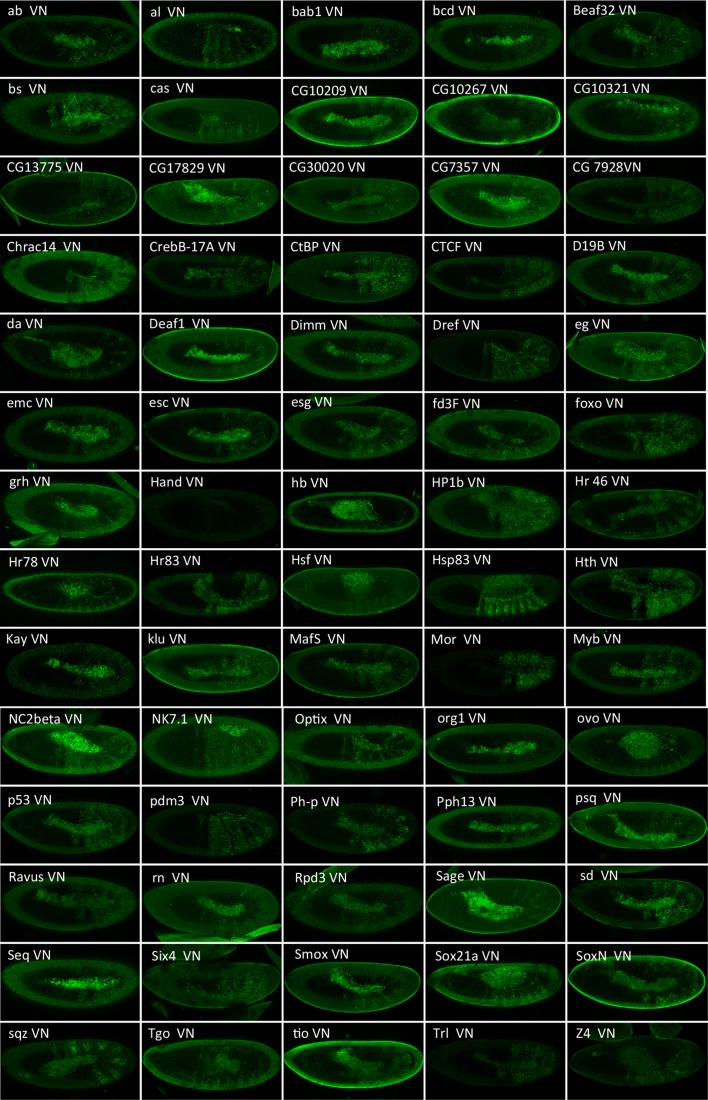
Illustrative confocal captures of Venus-based BiFC between ORF-VN and VC-Ubx, as indicated.Fusion proteins are expressed with the Ubx-Gal4 driver and BiFC analysed in the epidermis of stage 10 embryos.